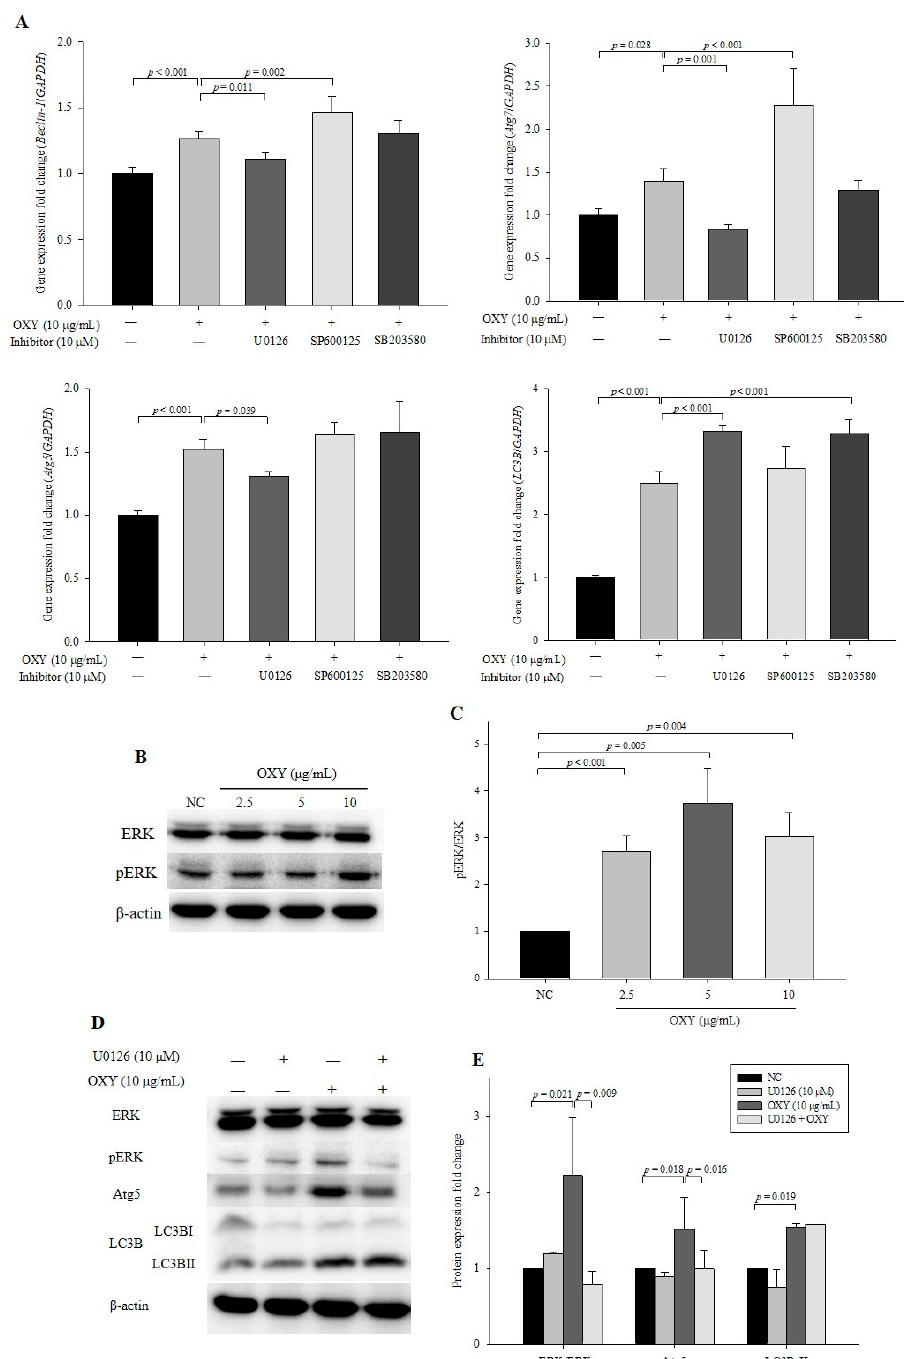
Figure 6. E ff ect of MAPK kinase inhibitors on the expression of autophagy-related genes and proteins. Cells were treated with OXY (10 µ g / mL) with or without MEK inhibitor (U0126), JNK inhibitor (SP600125), and p38 inhibitor (SB203580). Expression levels of Beclin-1 , Atg7 , Atg5 , and LC3B were determined by qPCR ( A ). Expression levels of phosphorylated ERK protein were measured by Western blotting ( B ) and quantified ( C ). Expression levels of phosphorylated ERK, Atg5, and LC3B proteins were measured by Western blotting ( D ) and quantified ( E ). From each lysate, equal amounts of protein were loaded on a separate gel, blotted for actin and this signal was used for determining the ratio of the protein of interest / actin as displayed in the figure. The cropped blots are representative of three independent experiments. The full-length blots are shown in Supplementary Figures S3 and S4. Each value indicates the mean ± SD of three independent experiments performed in